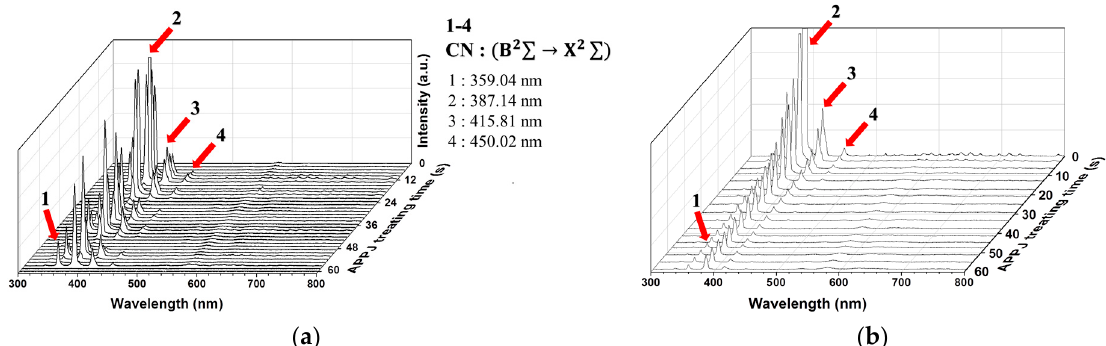
Figure 2. OES of plasma during ( a ) scan-mode and ( b ) stationary APPJ processing.